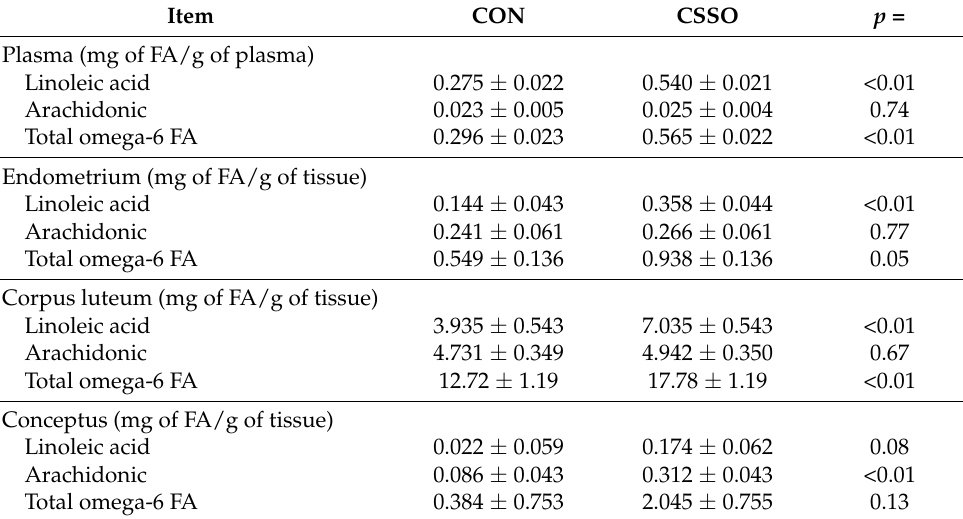
Table 1. Concentrations of fatty acids (FA) in samples collected on day 19 of gestation from B. indicus beef cows receiving or not (CON; n = 9) Ca soaps of soybean oil (CSSO; n = 9) after artificial insemination. Values reported are least square means ± standard error. Adapted from Cooke et al.